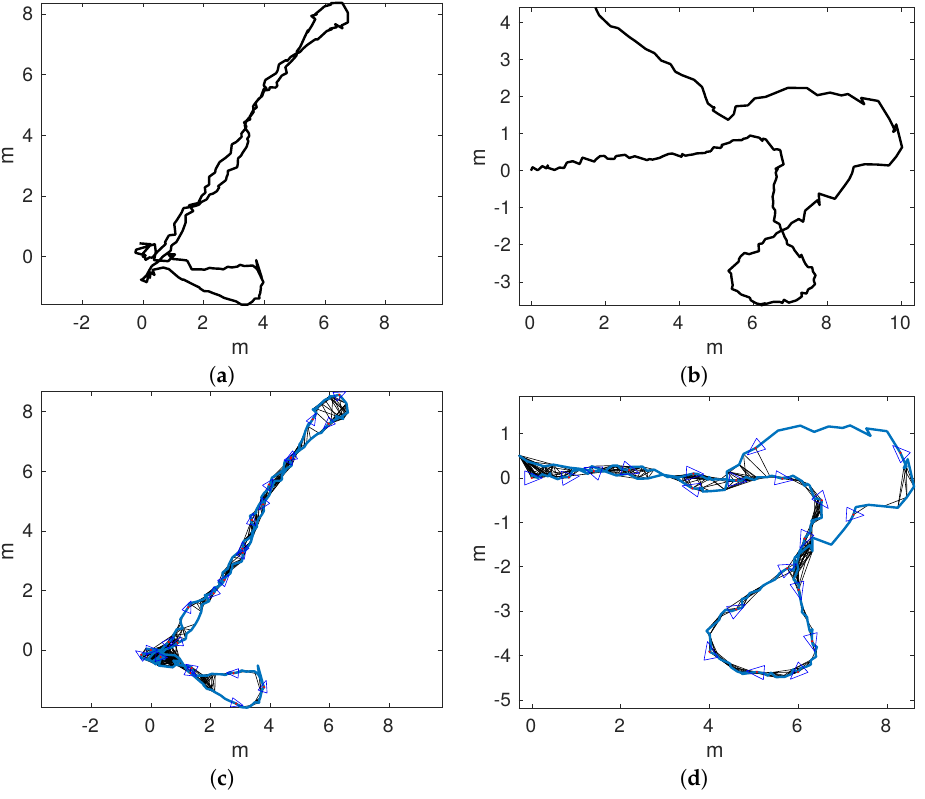
Figure 12. Obtained trajectories for V 1 and V 2: ( a ) Session 1 odometry, ( b ) session 2 odometry, ( c ) session 1 SLAM, and ( d ) session 2 SLAM.